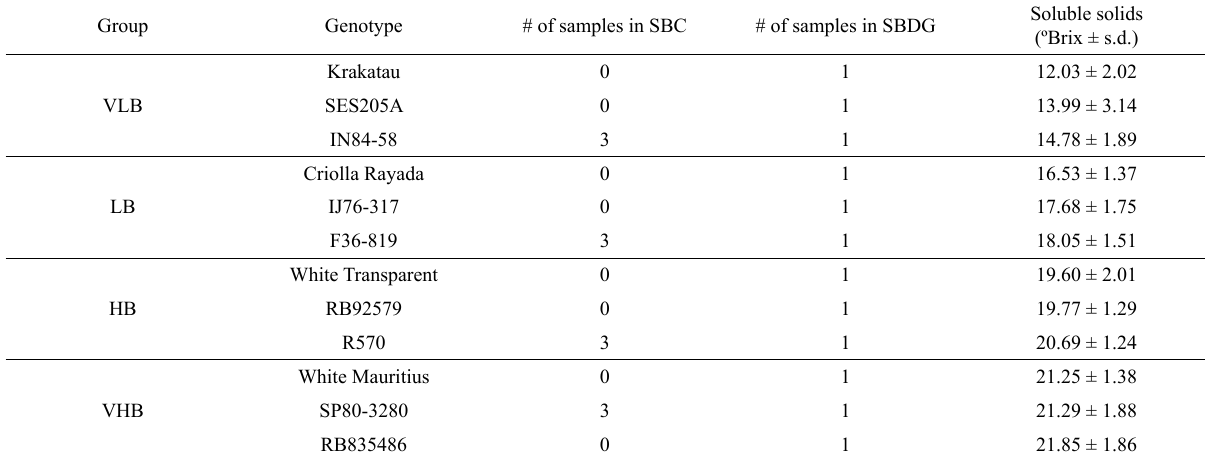
Table 1 – Genotypes selected to compose each ºBrix group for the strategy based on clones (SBC) and based on diverse genotypes (SBDG). In the former strategy, we sampled the immature internode +1 of three clonal replicates (R1, R2, and R3) for each genotype per group, and samples from three different genotypes per group for the latter. The genotypes IN84-58, F36-819, R570, and SP80-3280 were represented in both strategies, using samples from different plants. Group Genotype # of samples in